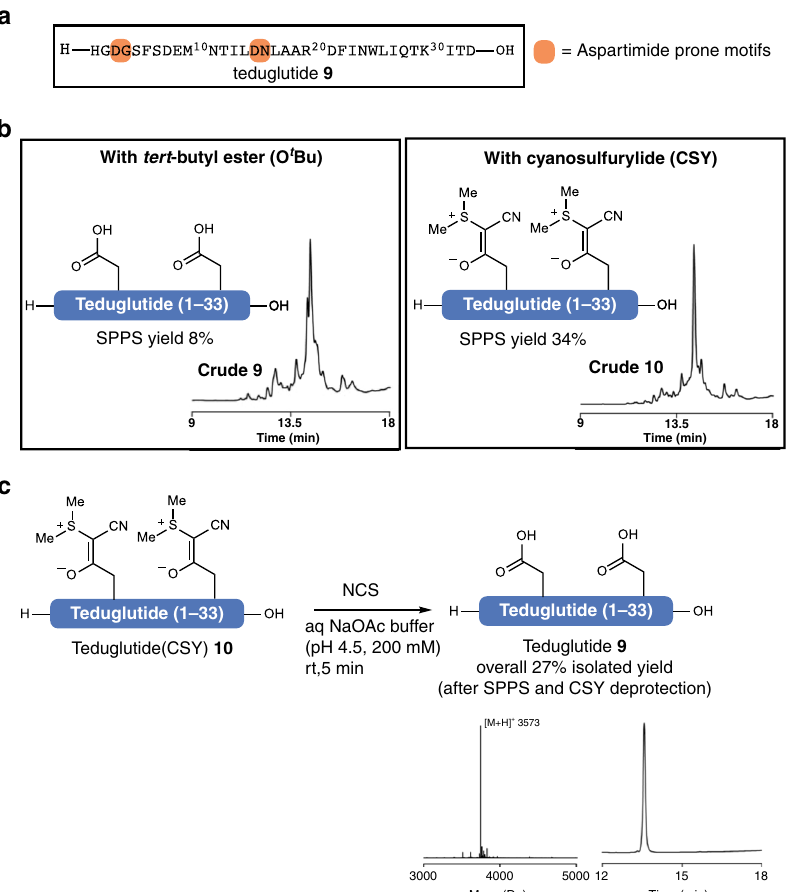
Fig. 4 Chemical synthesis of teduglutide using CSY. a Sequence of teduglutide 9 with motifs prone to aspartimide formation highlighted in orange. b SPPS synthesis was carried out using standard conditions. Synthesis of teduglutide 9 with conventional tert-butyl ester protected Asp showed signi fi cant amount of aspartimide, whereas no aspartimide was detected using cyanosulfurylide Asp(CSY) 3 for the synthesis of teduglutide(CSY) 10. c The cyanosulfurylides of teduglutide(CSY) 10 were removed under acidic conditions using